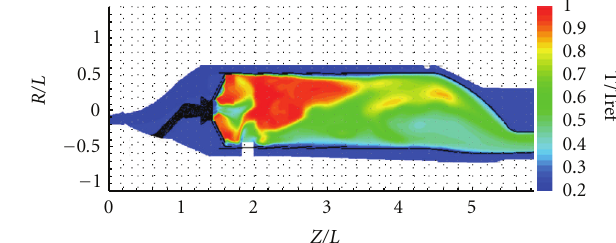
Figure 7: Temperature contours along the middle longitudinal plane.